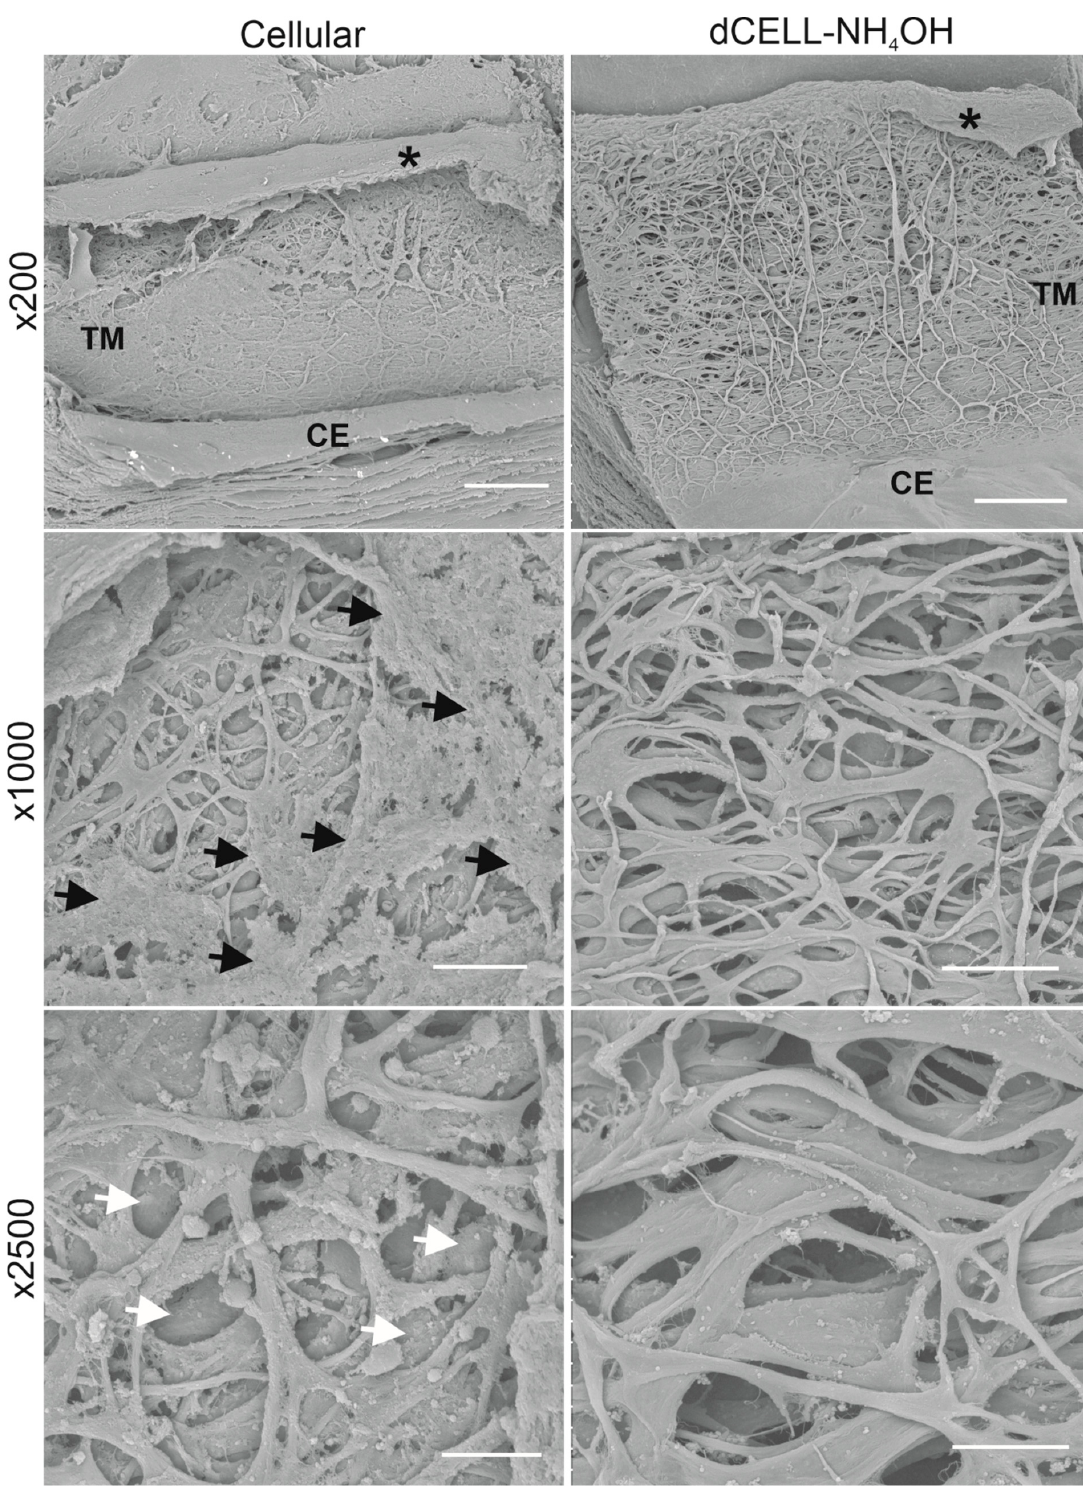
Figure 5. Representative scanning electron micrographs for cellular and dCELL–NH 4 OH human trabecular meshwork (magnifications x200, x1000 and x2500). Black arrows indicate presence of cells or cellular debris within the tissue. White arrows indicate blocked pores within tissue. Trabecular meshwork (TM) and corneal endothelium (CE) labelled in x200 image. * represents where the iris was removed to allow visualization of the TM. Scale bars = 200 µm (x200); 50 µm (x1000); 20 µm (x2500).